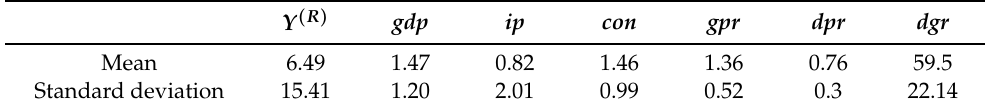
Table 2. The table shows the summary statistics for the dependent and forecasting variables. Y ( R ) is the stock return in excess of risk free rate; gdp the third to fourth quarter GDP growth; ip the third to fourth quarter industrial production growth; con the third to fourth quarter consumption growth; gpr the GDP-by-price ratio ; dpr the debt-by-price ratio and dgr the debt-by-GDP ratio. The sample period is